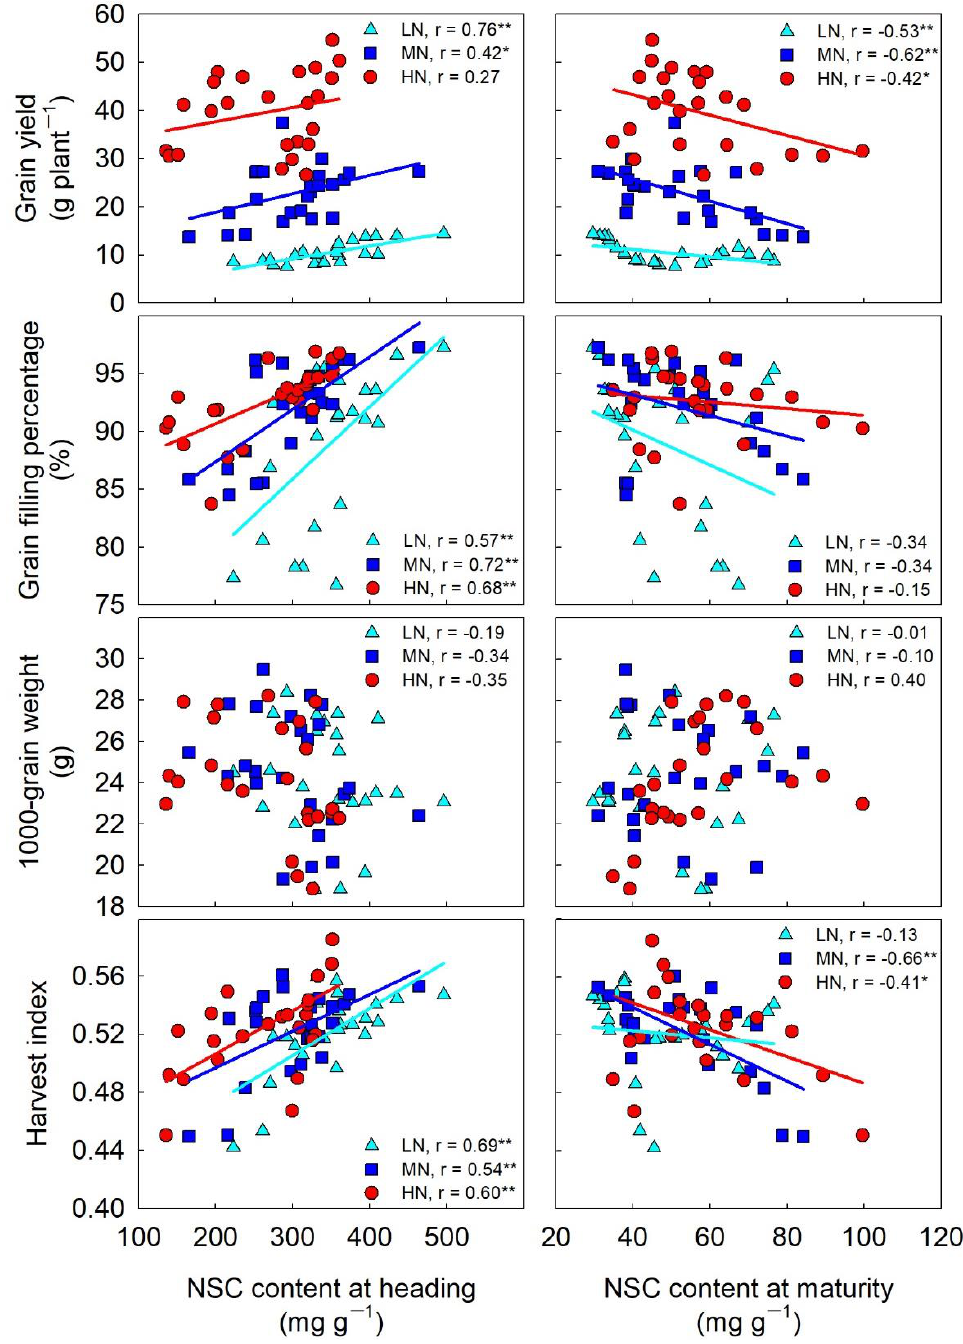
Figure 3. Correlations of yield-related traits with NSC content at heading and NSC content at maturity. * and **, significant at p < 0.05 and at p < 0.01, respectively. LN, low nitrogen; MN, medium nitrogen; HN, high nitrogen; NSC, non-structural carbohydrates.